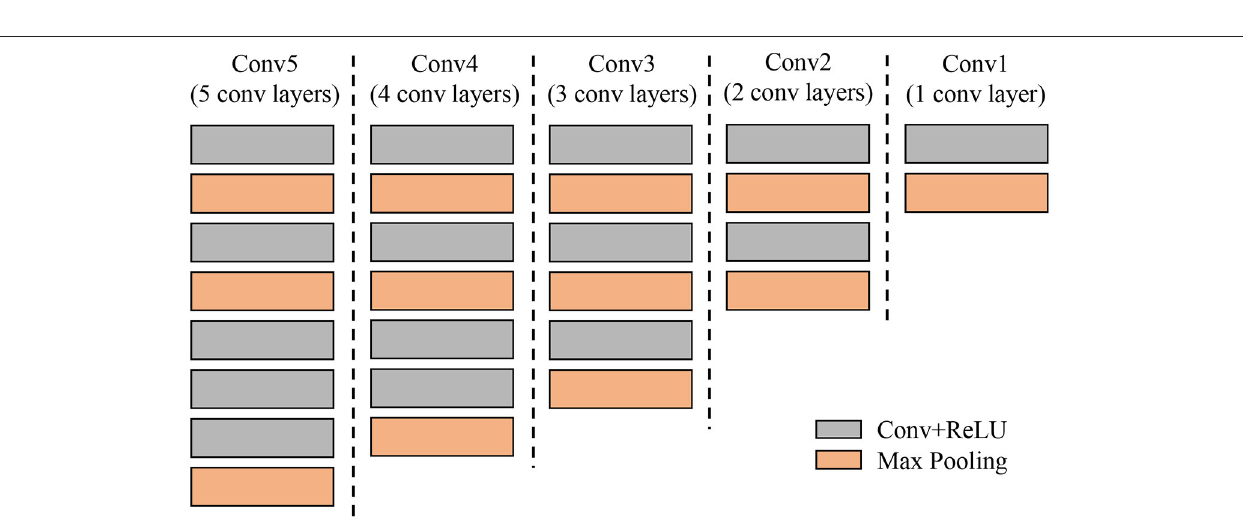
FIGURE 12 | Different designs of Convolutional Neutral Networks used in the experiments to understand the required parameters of the secondary diagnosis unit. Each column represents a single CNN from 5 to 1 convolutional layers (gray color).